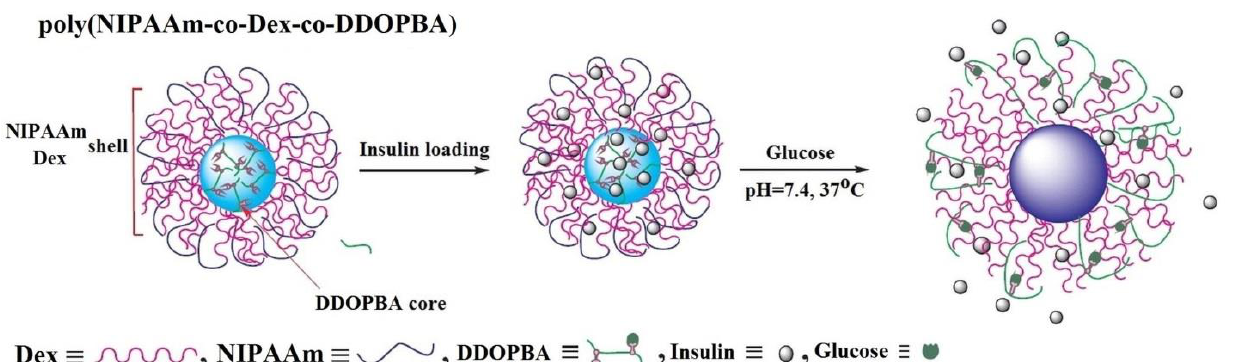
Figure 6. Schematic illustration of poly(NIPAAm- co -DEX- co -DDOPBA) nanogel as insulin delivery system (Adapted with permission from [82]. Copyright © 2023 Elsevier Ltd. All rights reserved).